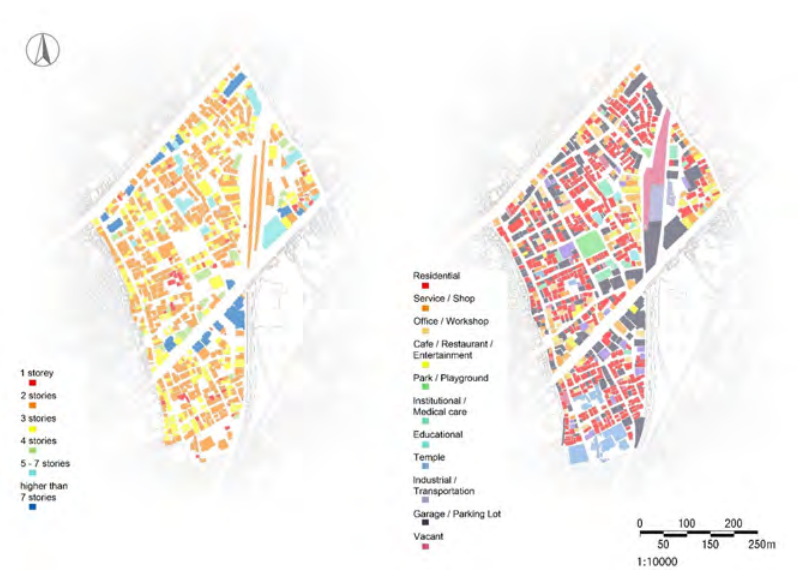
Figure 2. Buildings elevation plan and ground floor functions